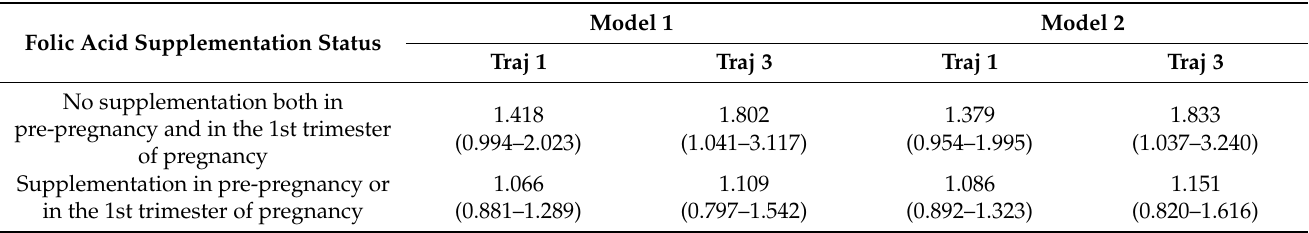
Table 3. Association of peri-conceptional folic acid supplementation status with body fat ratio trajectory in children 4–6 years of age [n = 2161, OR (95%CI)].